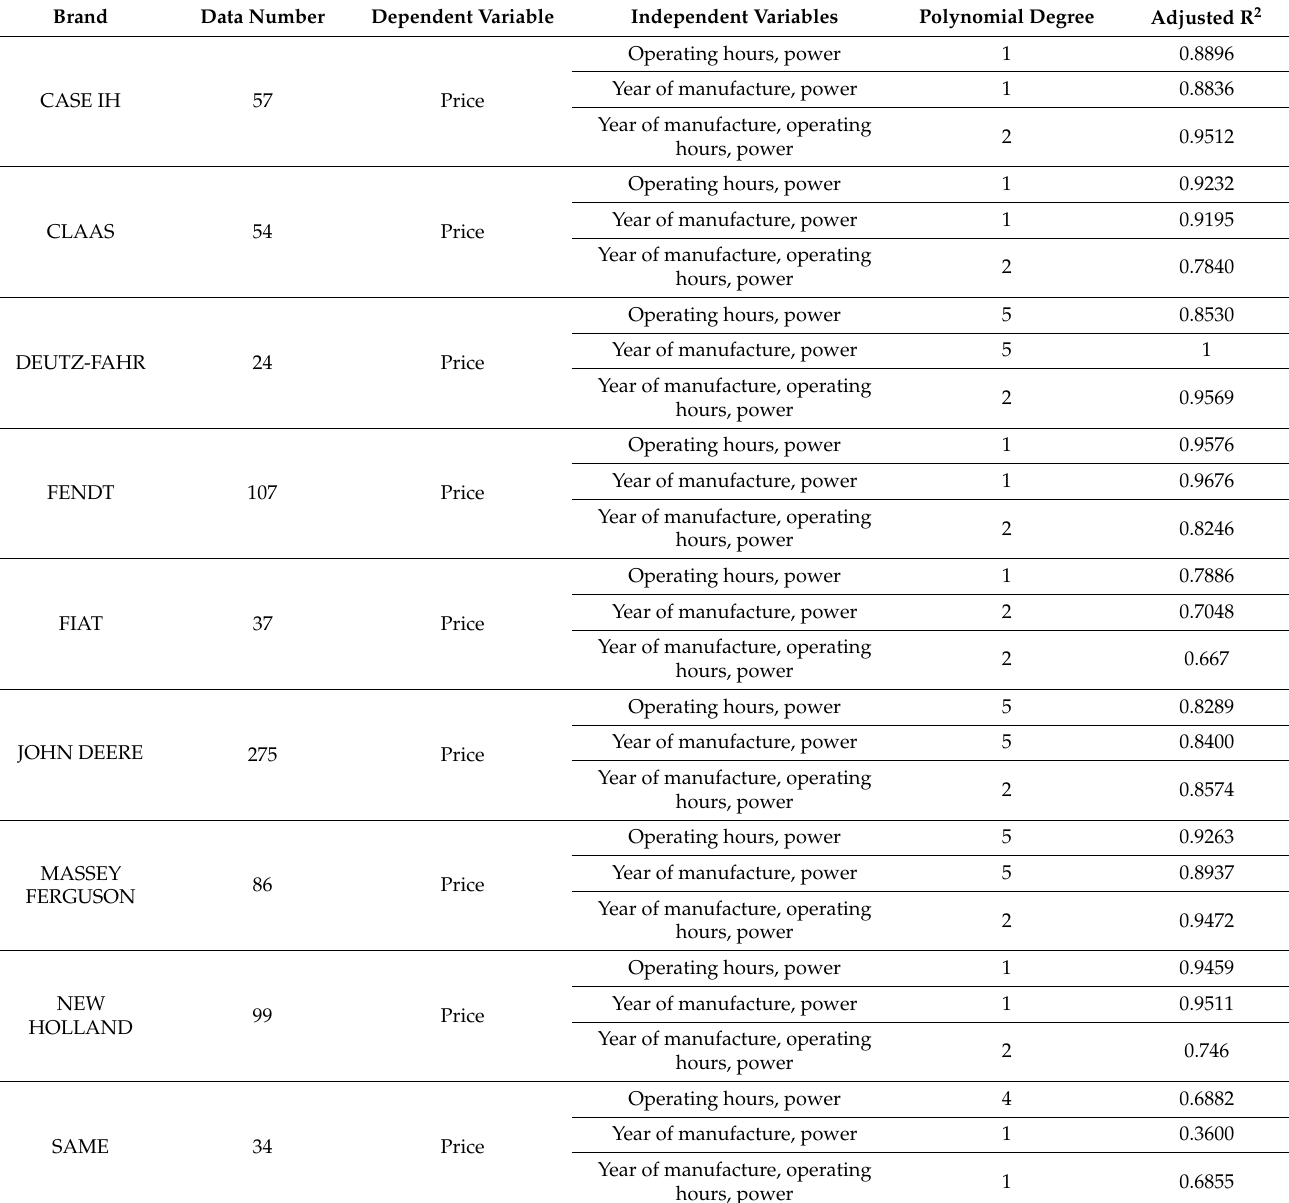
Table 11. Summary of results performing segmentation by brand in second-hand